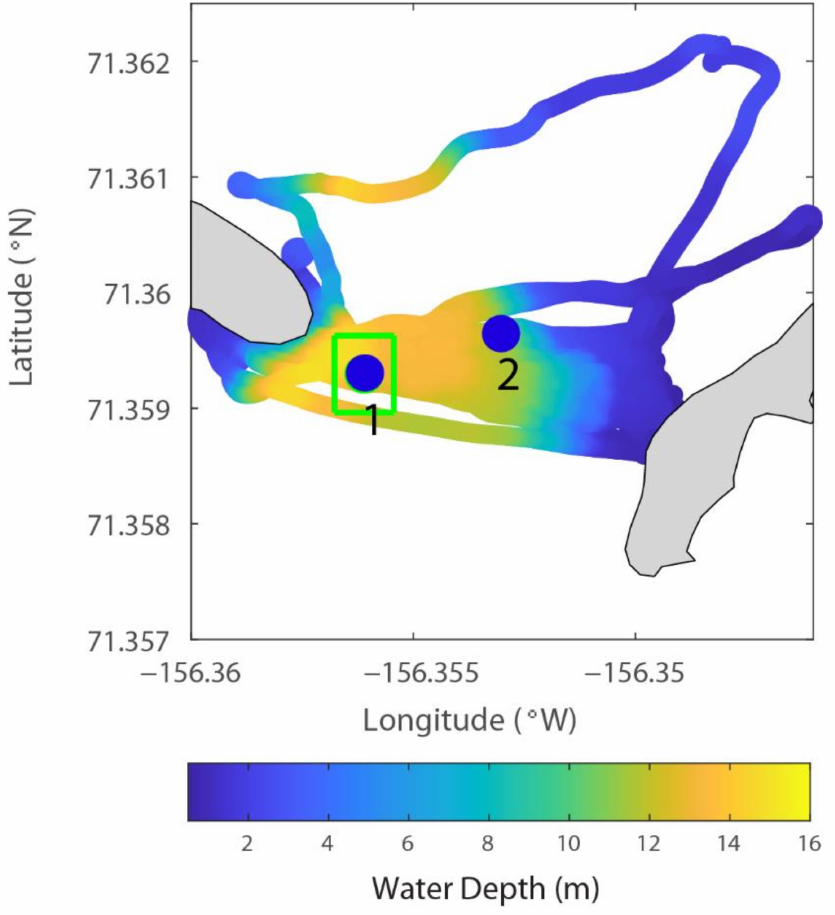
Figure 5. ADCP locations and water depth measured by the vessel-based M9 ADCP. The locations of the bottom-mounted ADCP are shown by the blue circles and the numbers (1 and 2) indicate the first and second deployments, respectively. The green rectangular box shows the region selected for capturing the flow velocity data from the vessel-based ADCP to compare with the flow data from the first